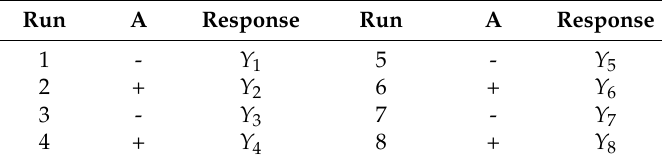
Figure 10. Main factors effects on the properties of the SR samples. Table 3. Example of the calculation of the main effect for one factor in a two-level, three-factor (2 3 ) factorial